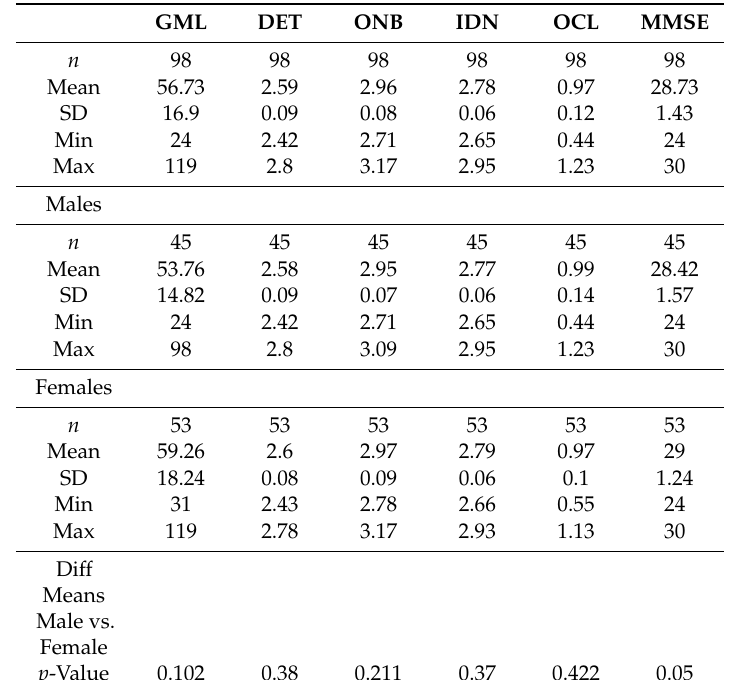
Table 3. Descriptive statistics for baseline scores across the CogState battery ( n = 98).